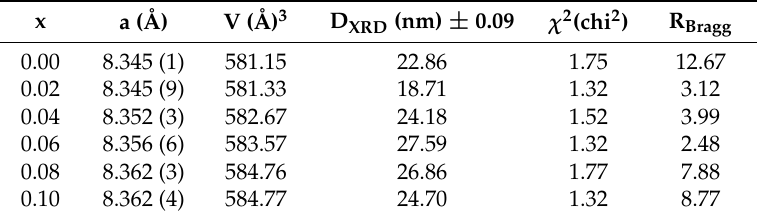
Table 1. Nb content and refined structural parameters (a is the lattice parameter, V is the volume of the cell, D XRD is the crystallite size obtained from the broadening of the highest peak by using the Scherrer method, χ 2 (chi 2 ) is the squared ratio, R Bragg is the Bragg factor) for the Co 0.5 Ni 0.5 Nb x Fe 2 − x O 4 (0 ≤ x ≤ 1.0) nanoparticles.